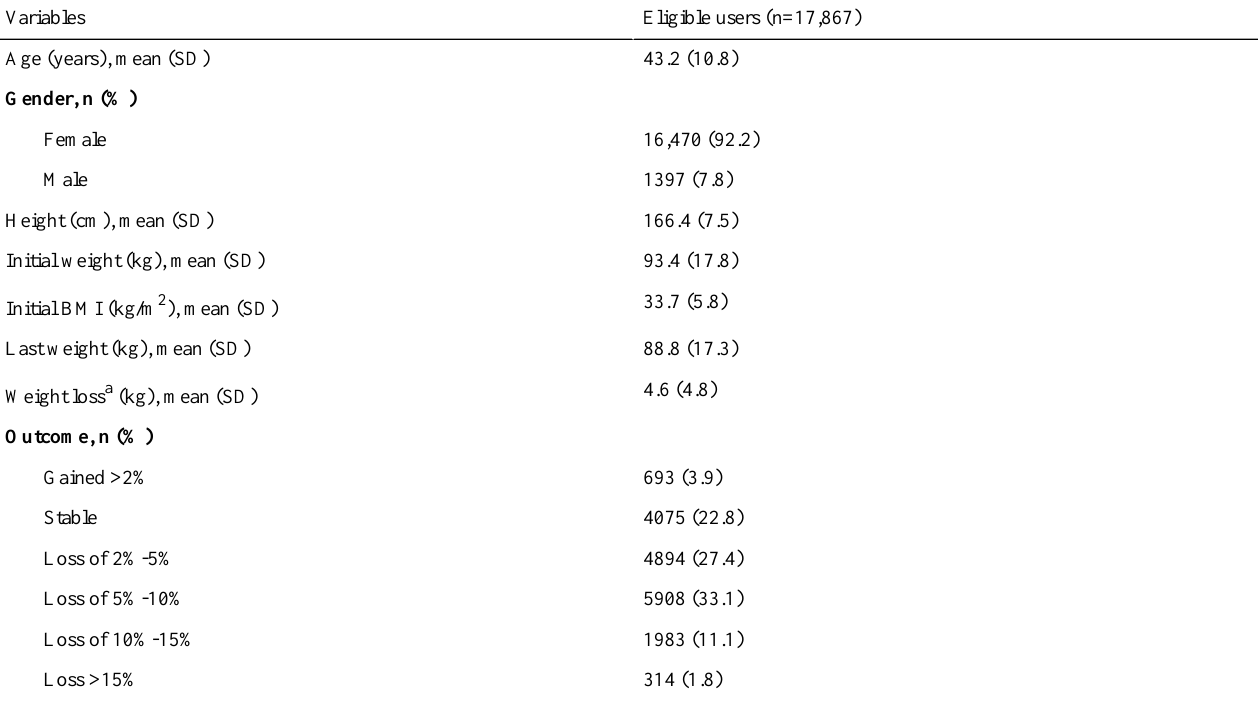
Table 1. Demographic characteristics of eligible